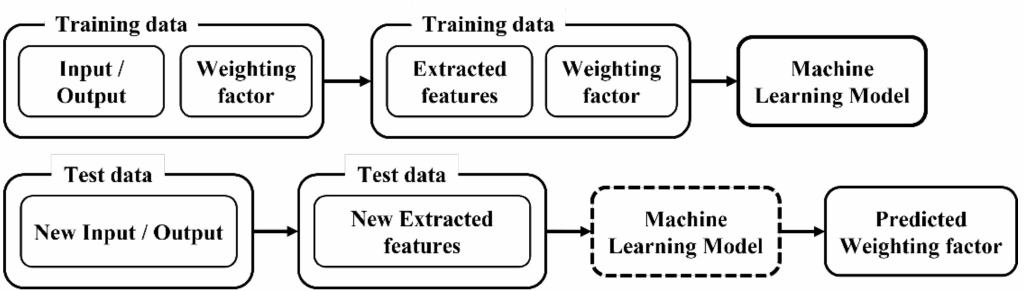
Figure 2. Outline of machine learning